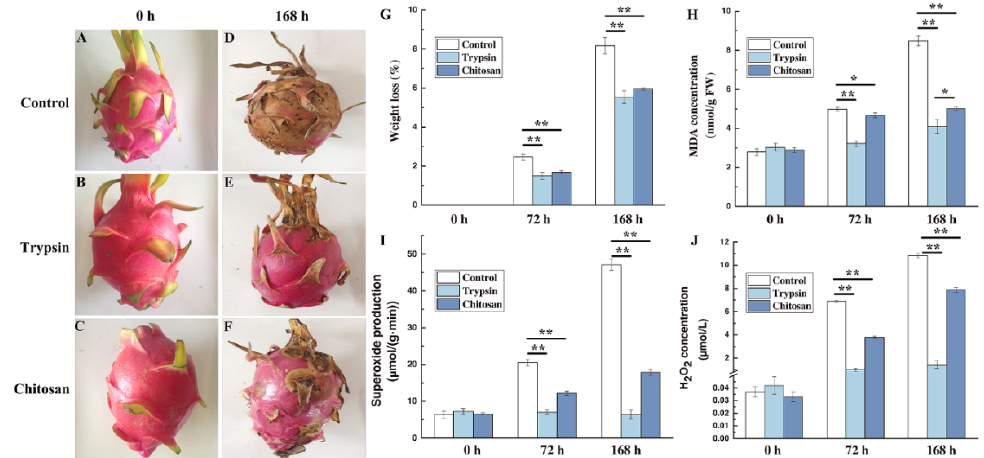
Figure 1. Effect of trypsin treatment on the storage quality or ROS levels of H. undatus . Values are the mean ± SE of triplicate samples. ( A – F ) Fruits of H. undatus stored at 25 °C for 168 h with and without trypsin or chitosan treatment. ( A,D ) Control fruits, ( B,E ) trypsin-treated fruits, ( C,F ) chitosan-treated fruits, 0 or 168 h represent that fruits were stored for 0 or 168 h, respectively, ( G ) weight loss of H. undatus fruit stored with or without trypsin or chitosan for 72 or 168 h, ( H ) malondialdehyde MDA contents of H. undatus fruit stored with or without trypsin or chitosan for 72 or 168 h, ( I , J ) superoxide anion production rates, or H 2 O 2 concentrations in H. undatus peel with or without trypsin or chitosan for 72 or 168 h. * represented significant difference ( p < 0.05); ** represented highly significant difference ( p < 0.01).